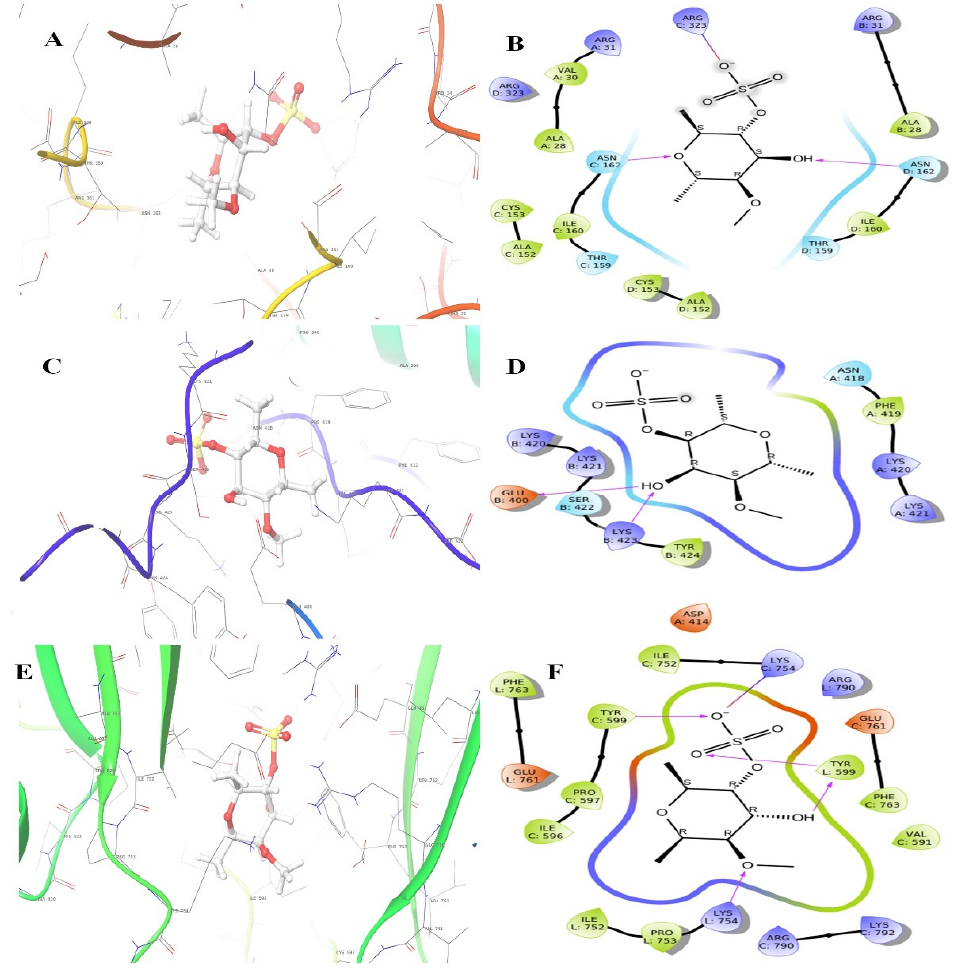
Figure 11. The three-dimensional and two-dimensional structure of docked compound (fucoidan) with antioxidant target proteins were depicted. ( A , B ) represents the NADPH oxidase, ( C , D ) for cy-